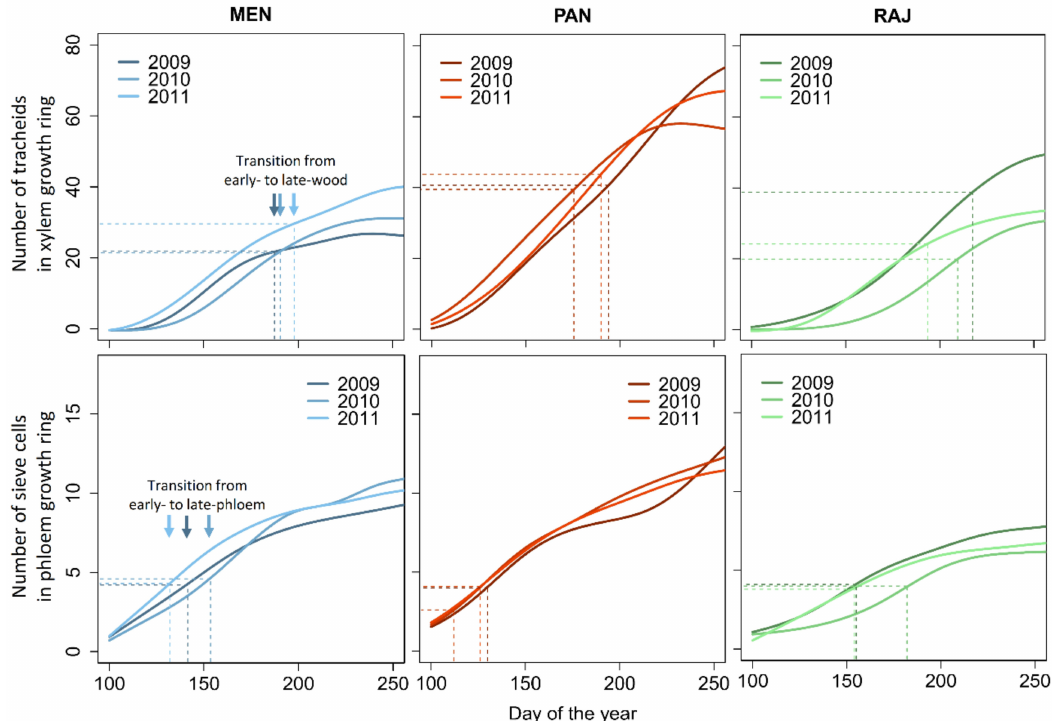
Figure 1. Inter-annual dynamics of wood and phloem growth ring formation represented by generalized additive models (GAMs) fitted to weekly wood and phloem increments in Norway spruce at MEN, PAN, and RAJ. Horizontal and vertical dashed lines indicate the number of cells and the average date of the transition from earlywood to latewood and early to late phloem in particular